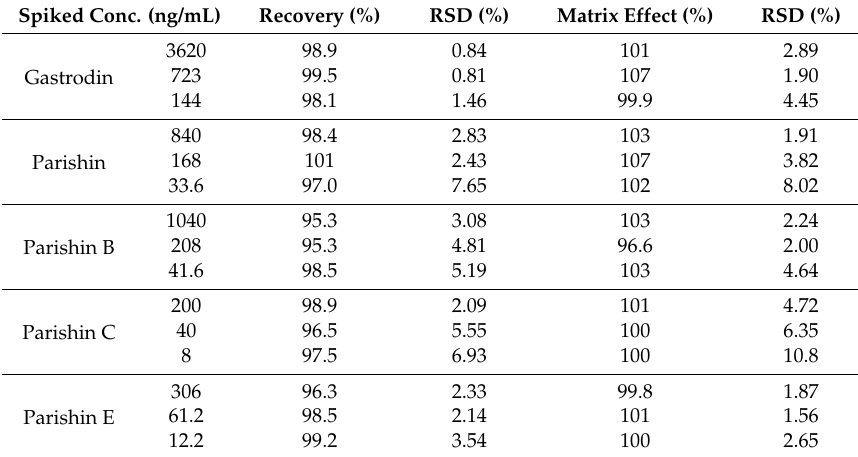
Table 2. Recovery and matrix effect of gastrodin, parishin, parishin B, parishin C and parishin E in beagle dog plasma ( n =